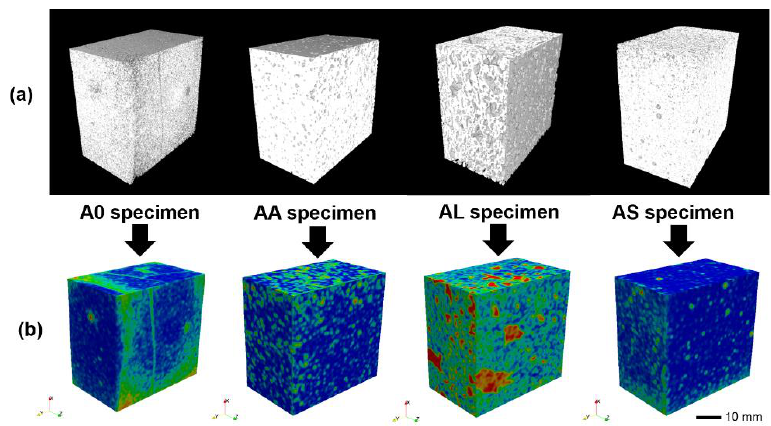
Figure 7. Target specimens (A0, AA3, AL3, AS3) and their 3D binarized CT images (solid structures): ( a ) 3D binarized CT images (solid structures) of A0, AA3, AL3, and AS3 specimens (Note: in the binary images, the white denotes solid phase, and the black parts represent the pores of each specimen); ( b ) description of pore densities of the specimens (Note: the color in each figure denotes pore density values between 0 (blue) to 1 (red)).